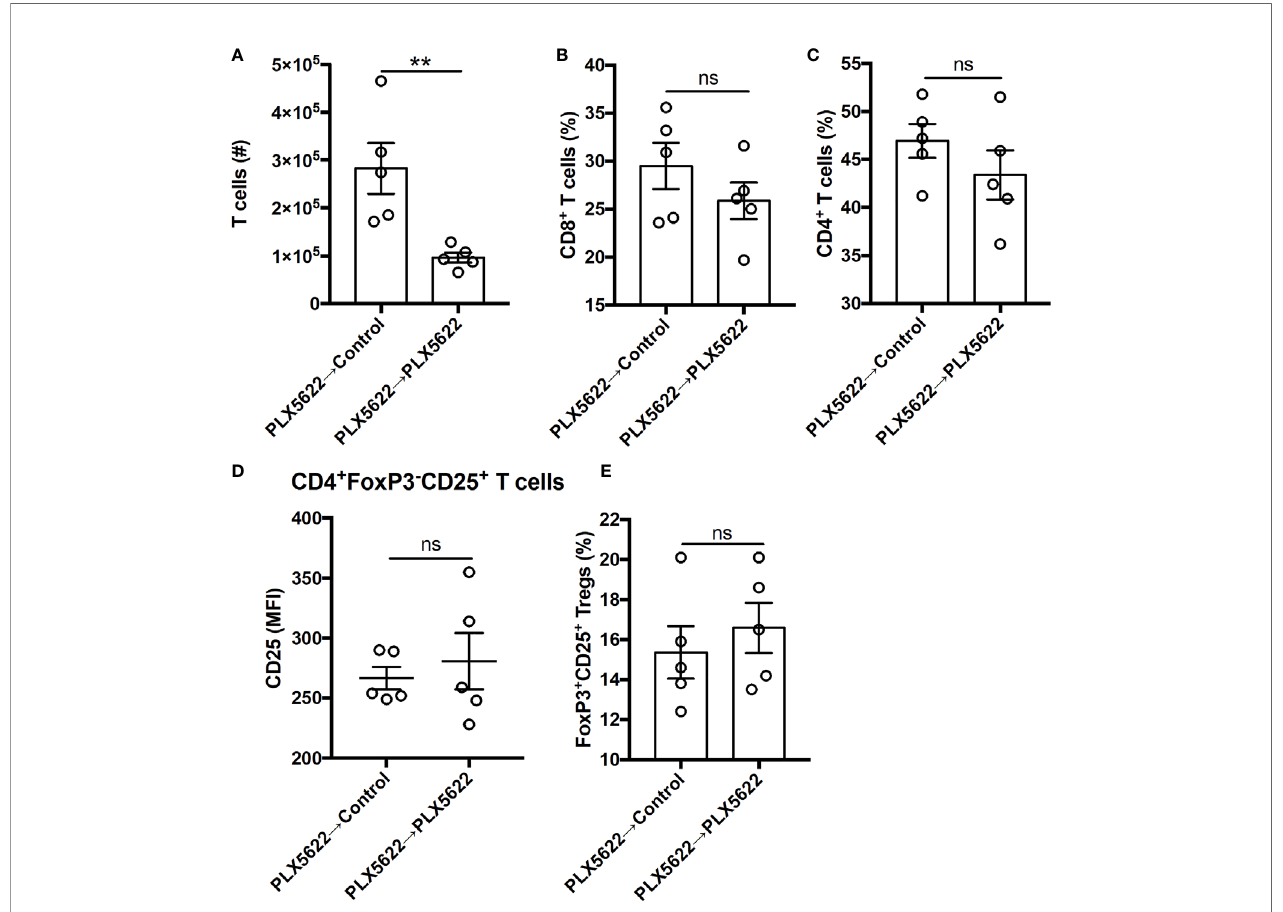
FIGURE 6 | De fi cits in CNS T cell in fi ltration in chronically infected, microglia-de fi cient SJL/J mice can be reversed by discontinuing PLX5622. SJL/J mice were treated with a PLX5622-supplemented diet seven days prior to i.c. TMEV infection, switched to a control diet or remained on the PLX5622-supplemented diet at 47 DPI, and were sacri fi ced at 77 DPI for analysis (n = 5 mice per group). (A) Number of CNS T cells. Proportion of (B) CD8 + T cells and (C) CD4 + T cells of CNS CD3 + T cells. CD25 expression in CNS CD4 + FoxP3 - CD25 + T cells. (E) Proportion of CD4 + FoxP3 + CD25 + Tregs of CNS CD4 + T cells. Data are presented as mean ± SEM. **P ≤ 0.01, ns, not signi fi cant; Student t test for (A – E)